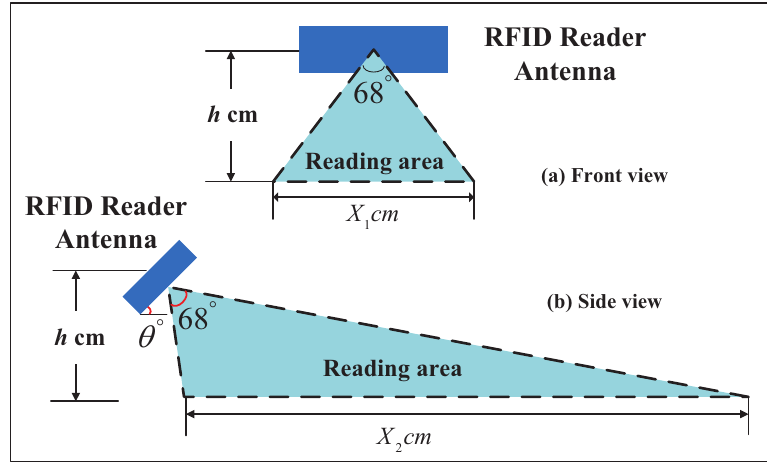
Figure 2. The reading area of RFID